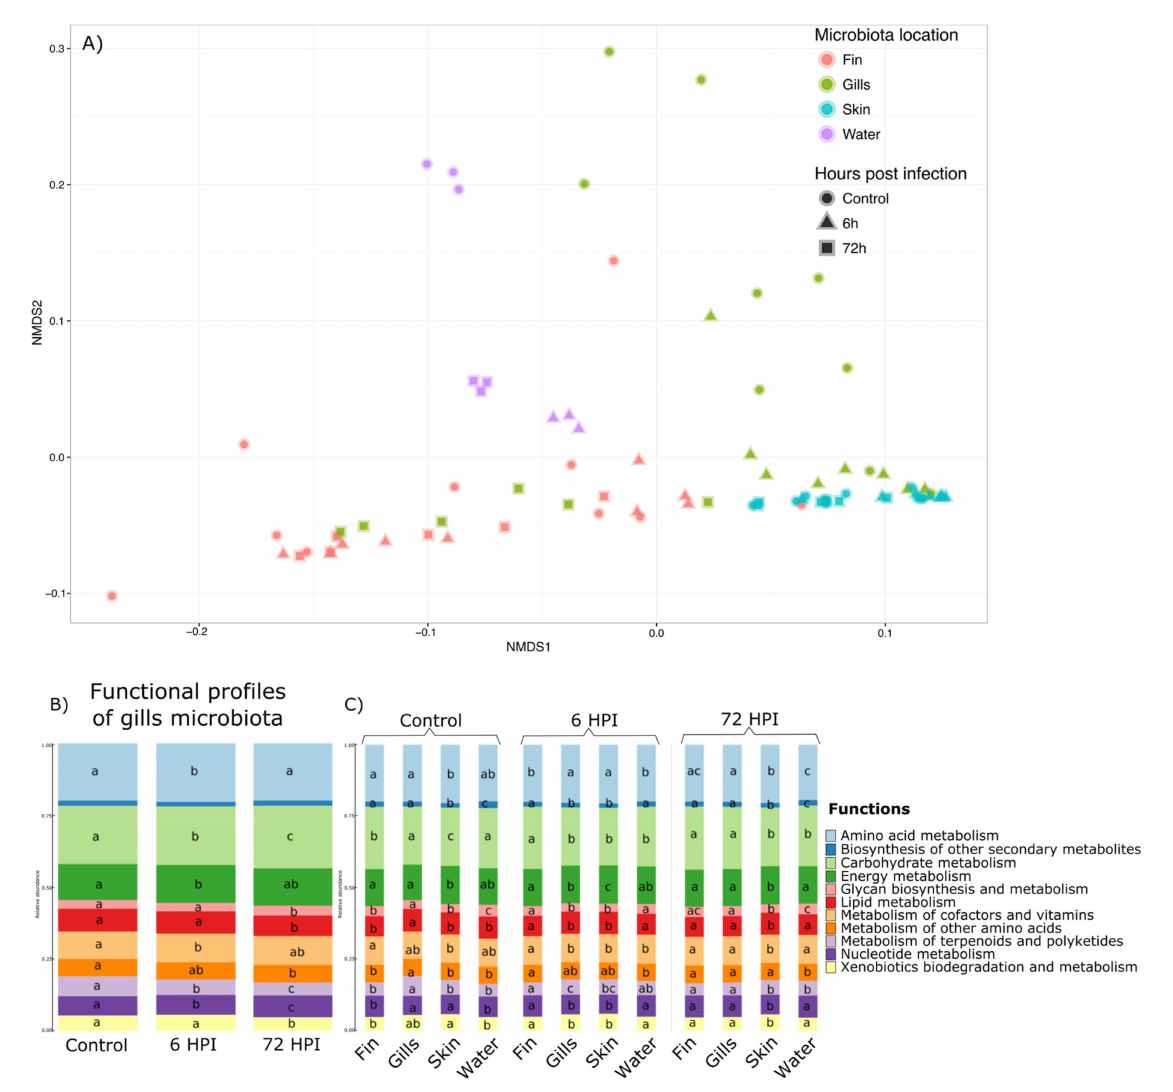
Figure 4. Tax4Fun analysis for the prediction of functional profiles of the rainbow trout microbiota. ( A ) Nonmetric multidimensional scaling clustering microbial communities using Bray–Curtis distance of 6324 KEGG orthology pathways. The samples were clustered following this: circles represent the group before the infection condition, triangles represent the 6 h post-infection condition, and the squares represent the 72 h post-infection condition. Samples were also colored by the microbiota location (blue: skin microbiota; red: fin microbiota; green: gills microbiota; and purple: bacterial community of the water). ( B ) Bar plots of the functional profiles of the gill microbiota in the group before the infection, 6 and 72 hpi. Letters represent the statistical differences observed by GLM analyses. ( C ) Bar plots of the functional profiles of the different microbiota in the group before the infection, 6 and 72 hpi. Letters represent the statistical differences observed by GLM